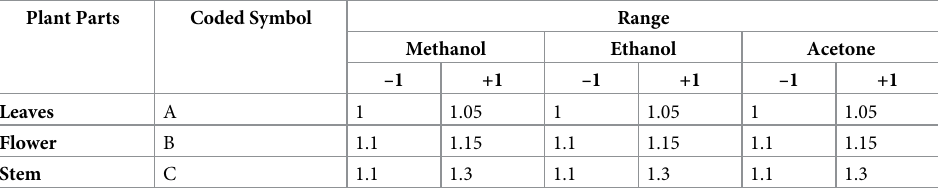
Table 3. A design approach for determining the optimization of antidiabetic activity of A . absenthia via Box- Behnken design. Plant Parts